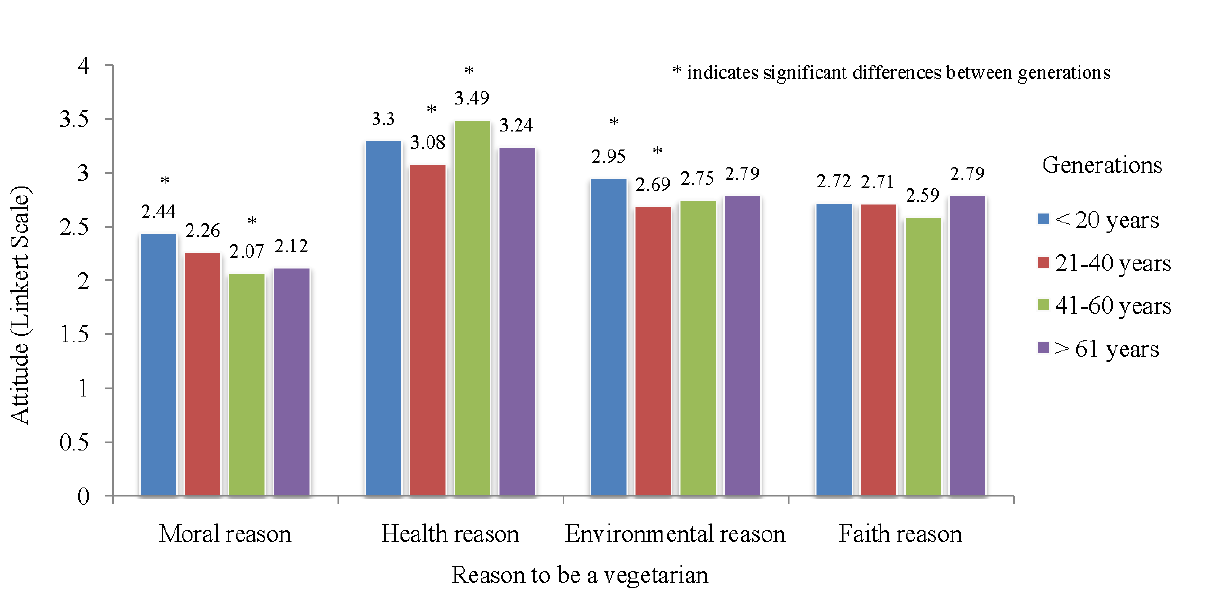
Figure 1 . Distribution of attitudes concerning different reasons to be vegetarian across